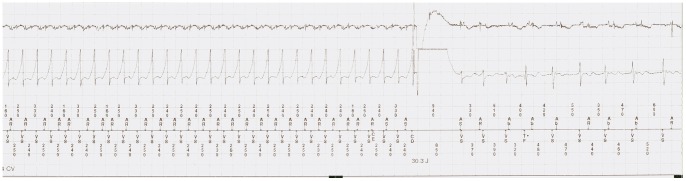
Intracardiac electrogram recording of a 49-year-old woman with ARVC and an implanted dual-chamber ICD.A sustained monomorphic ventricular tachycardia with a rate of 250 beats/min is appropriately detected by he device and terminated by an appropriate shock (30.3 Joule).